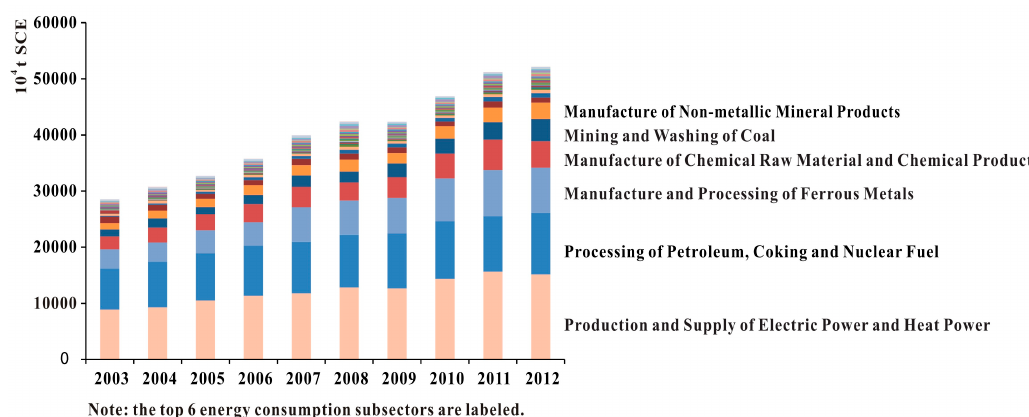
Figure 1. The industrial energy consumption of NOIB by subsector, 2003–2012. Table 2. Impact of different factors on the changes of industrial energy consumption in NOIB, 2003–2012.